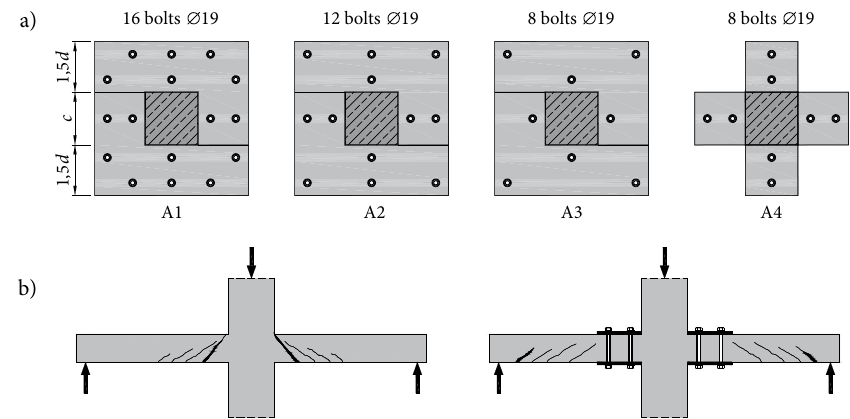
Figure 3. Specimens considered in the experimental investigations of Ebead and Marzouk (2004): a) the method of strengthening, b) typical crack pattern at saw-cuts of the specimens after the test (non-strengthened and